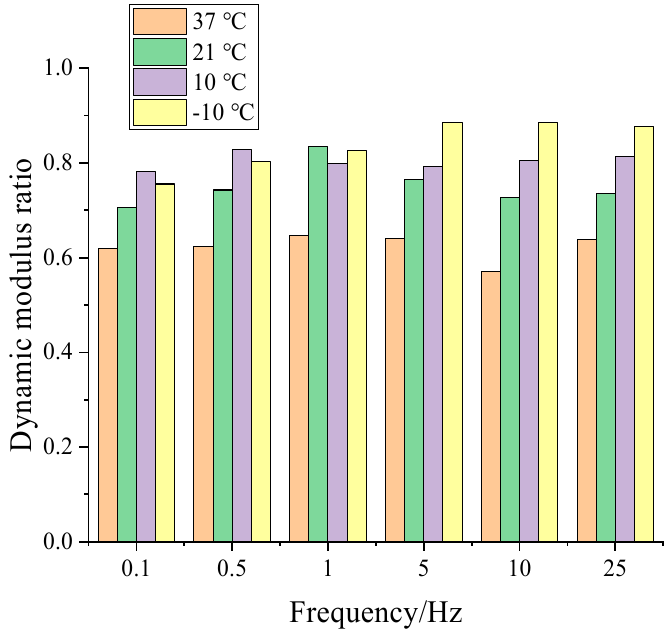
Figure 10. Dynamic modulus ratio of pre-mist and post-mist CIR mixture at 10Hz.